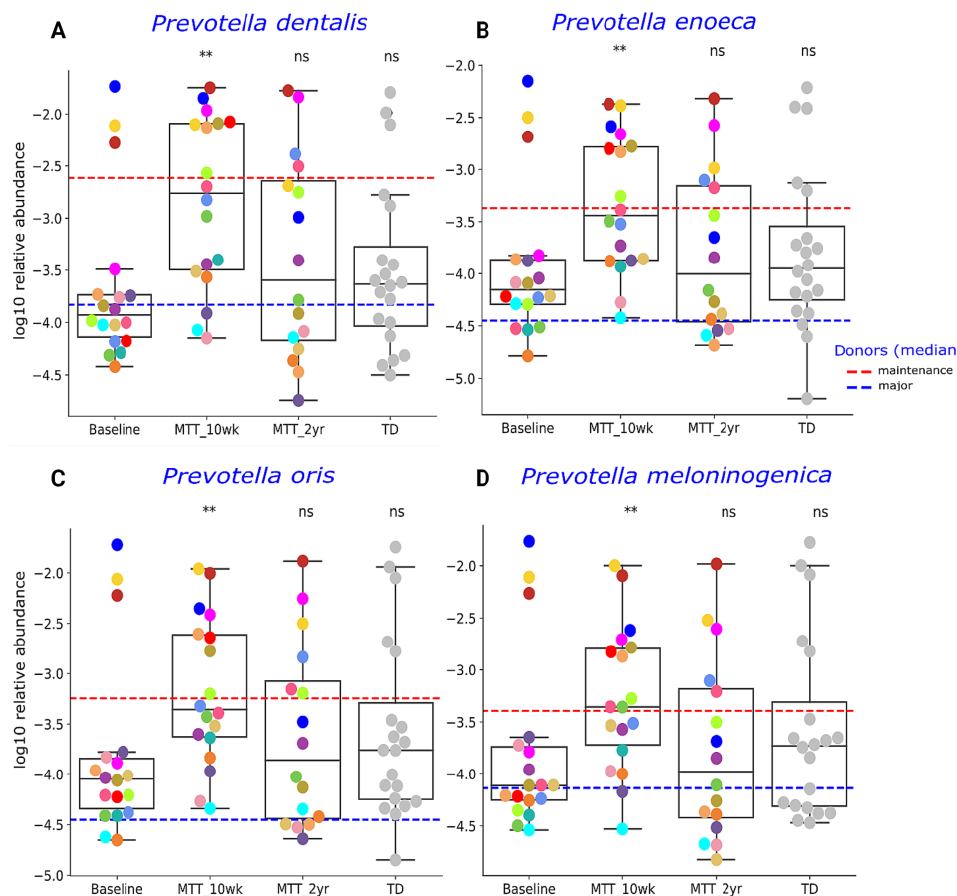
Figure 3. Univariate comparison of the relative abundance (after log 10 transformation) of ( A ) P. denatalis , ( B ) P. enoeca , ( C ) P. oris , and ( D ) P. meloninogenica of ASD Baseline vs. MTT (10 wk, 2 yr) and TD. Red-dashed lines represent the mean of maintenance ( n = 2) and blue represent median of major donors ( n = 5). Each colored dot represents one ASD individual and grey-colored dots represent TD. Asterisks represent significant differences between ASD Baseline and the other groups ** double asterisks indicate p < 0.01; ns: not significant; all p -values are FDR-corrected). ASD: autism spectrum disorder, TD: typically developing.